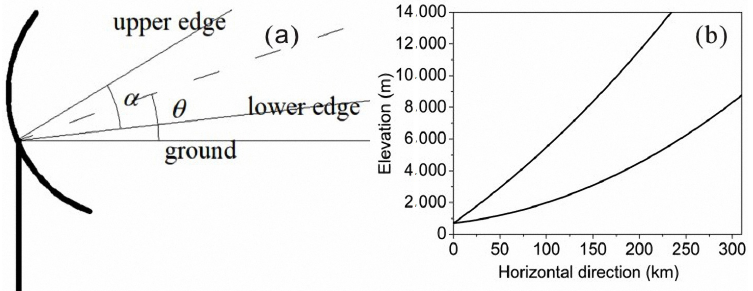
Figure 11. Elevation angles and propagation paths: ( a ) Relation between transmitting antenna beam angle and elevation angle. ( b ) Radio wave propagation paths at different elevation